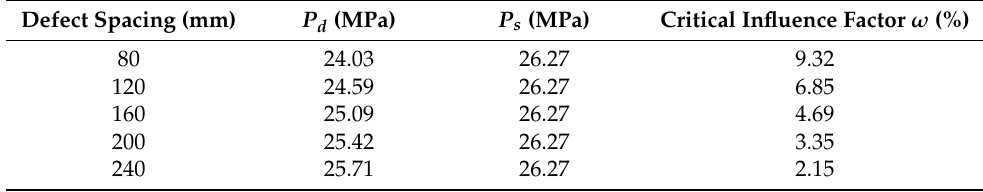
Table 3. Example of the calculation of the critical influence